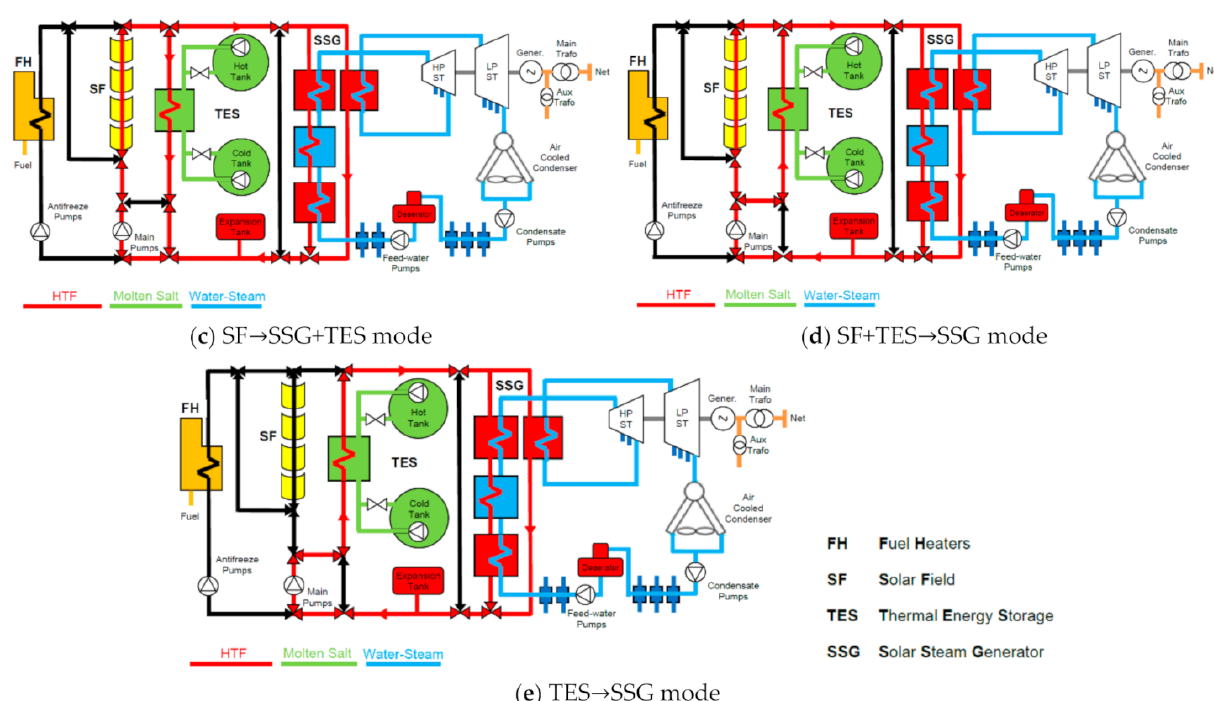
Figure 3. Generic parabolic trough operation